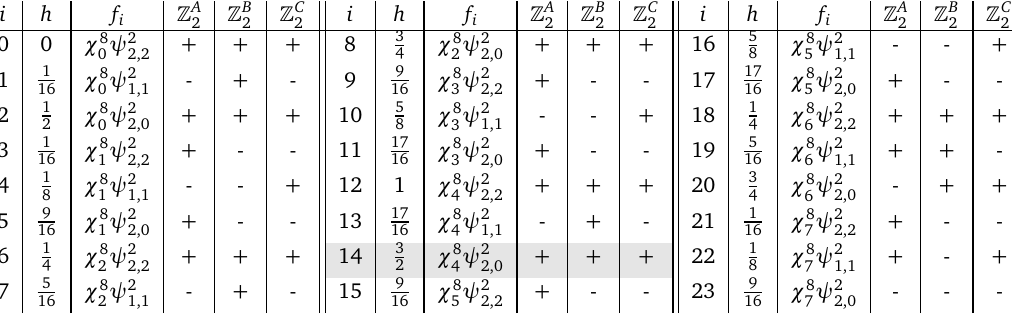
of 24 primaries ( i = 0,1, ··· ,23) i theory and the Ising model, denoted by 8 symmetry of the 2